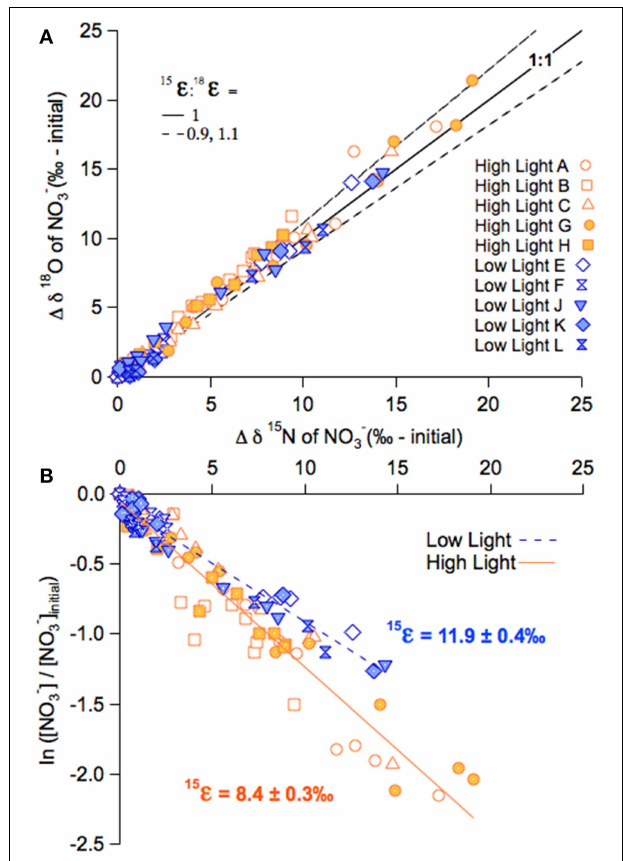
FIGURE 5 | NO − 3 isotope dynamics of the late summer incubations. (A) The change in NO − 3 δ 18 O ( δ 18 O minus δ 18 O initial ) plotted on the corresponding change in δ 15 N in the high-light and low-light summer incubations, for both unlabeled and labeled treatments. (B) NO − 3 δ 15 N plotted vs. the logarithm of the fraction of NO − 3 remaining for the high-light and low-light summer incubations, for both labeled and unlabeled treatments. The respective slopes of the linear relationships approximate 15 ε